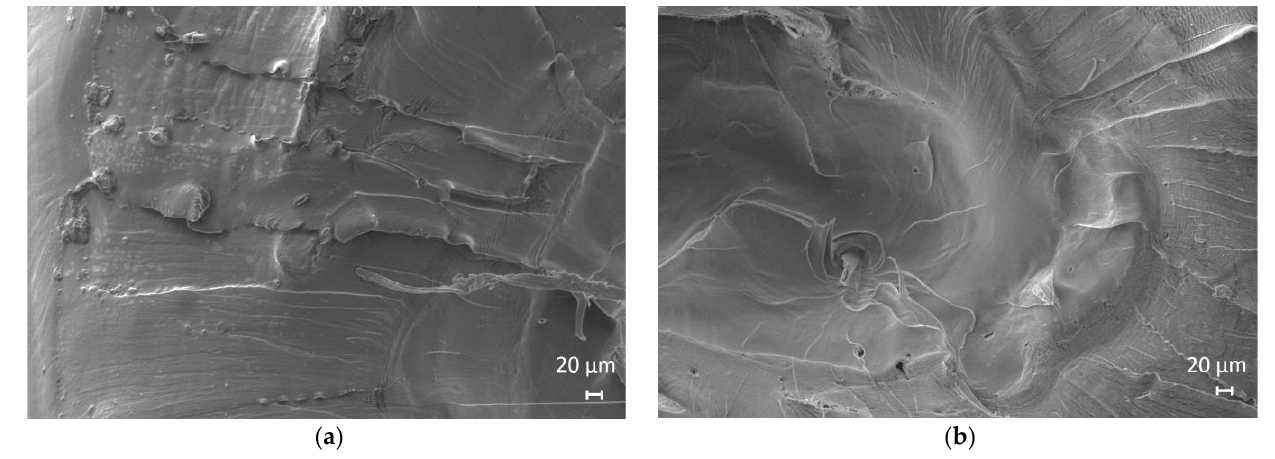
Figure 4. Scanning electron microscopy (SEM) images obtained examining the cross-sections induced at the end of tensile tests at the break of dumbbell specimens for ( a ) PLA − 4 − 20 and ( b ) PLA − 4 − 30.